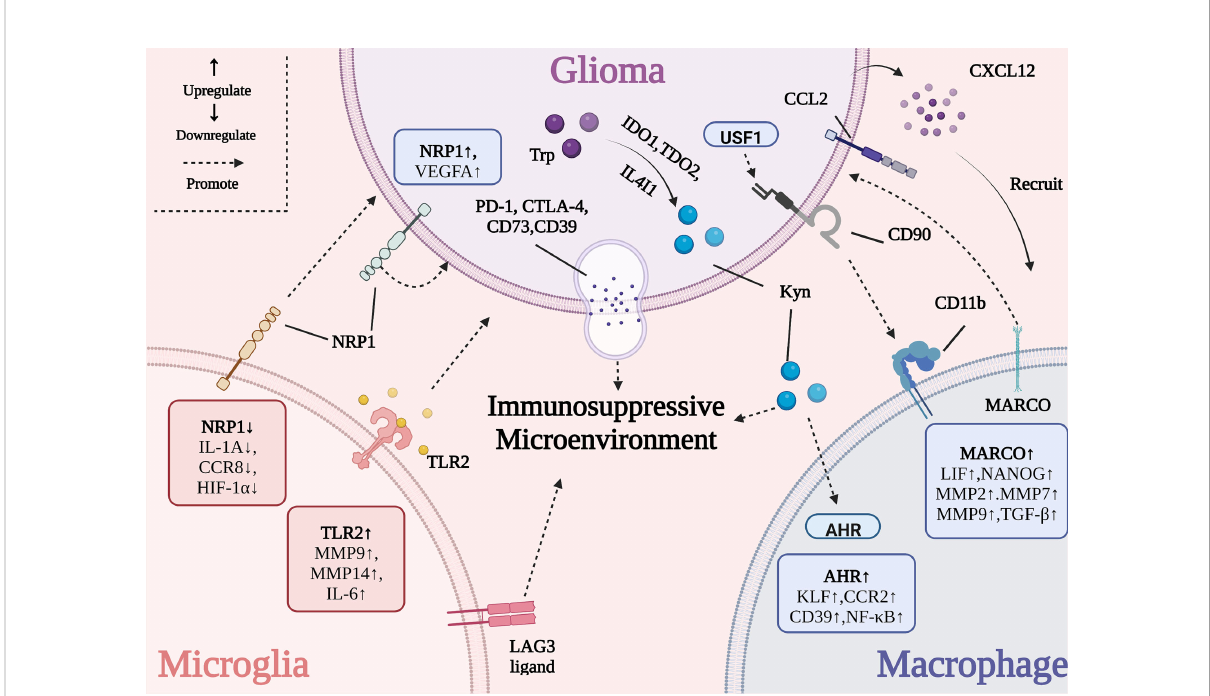
FIGURE 1 The interactive mechanism between GBM and TAMs. The activation of tumor-promoting genes (e.g., Tlr2 , Marco , and Ahr ) in TAMs in fl uences tumor growth, metastasis, angiogenesis and immune evasion. The overexpression of some genes in GBM (e.g., Ido1 , Tdo2 , Il4i1 , and Usf1 ) damages the activity of